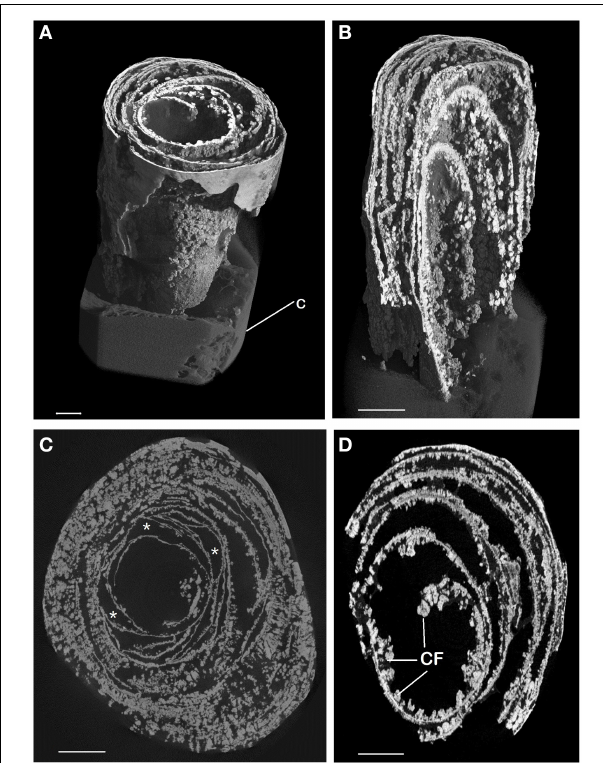
FIGURE 3 | Micro CT scan of CaCO 3 stalactite. (A) General habitus of CT scan of CaCO 3 stalactite that contained nematodes. The area shown is near the tip of the soda straw at the bottom of the stalactite away from the ceiling. The bent laminae are clearly visible as is the knob like outgrowths on them. Cotton (C) was used to stabilize the stalactite for scanning. (B) Longitudinal section inside the lower part of image (A) . The lamellar built of the stalactite and the outgrowths are plainly visible. (C,D) Cross sections of the stalactite in an area close to the ceiling (C) and near the end (D) . Outgrowths can become very dominant and the laminae can form complete or partially enclosed spaces ( * ) within the inner stalactite. Scale bars: (A) 4cm, (B) : 0.1cm, (C) : 7cm, (D) : 5cm.